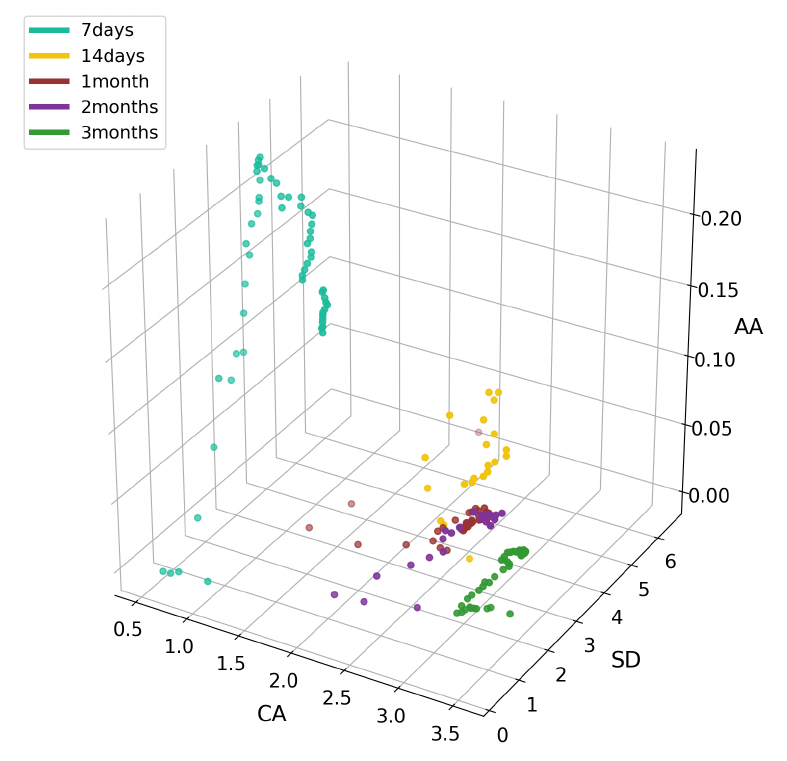
Figure 8. Dependence of objects in classes from CA, SD and AA